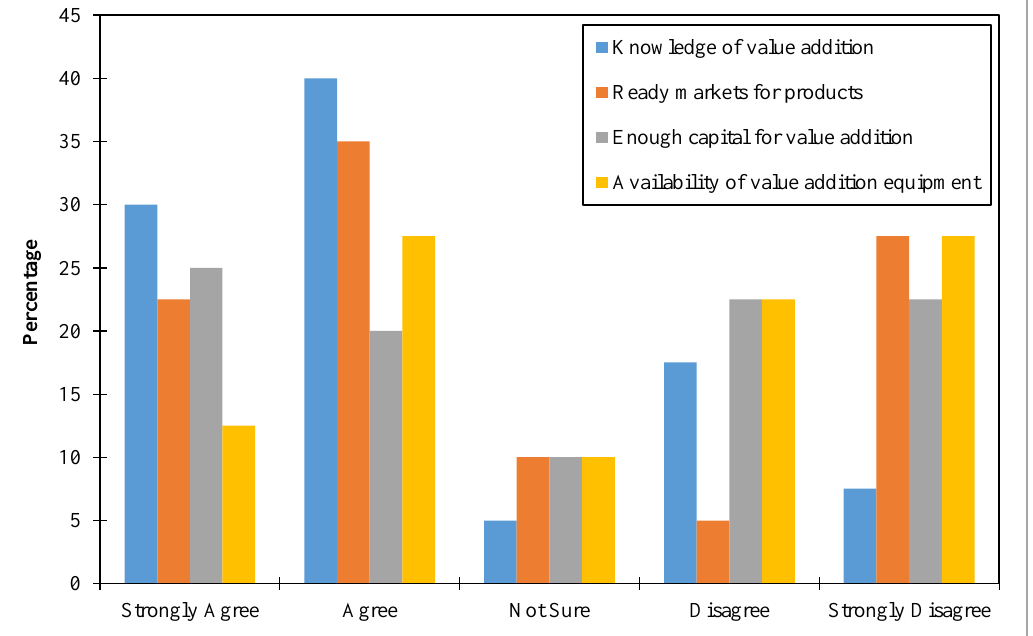
Figure 6. Factors that influence Irish potato value addition among smallholder farmers X 2 =8.020; df=3